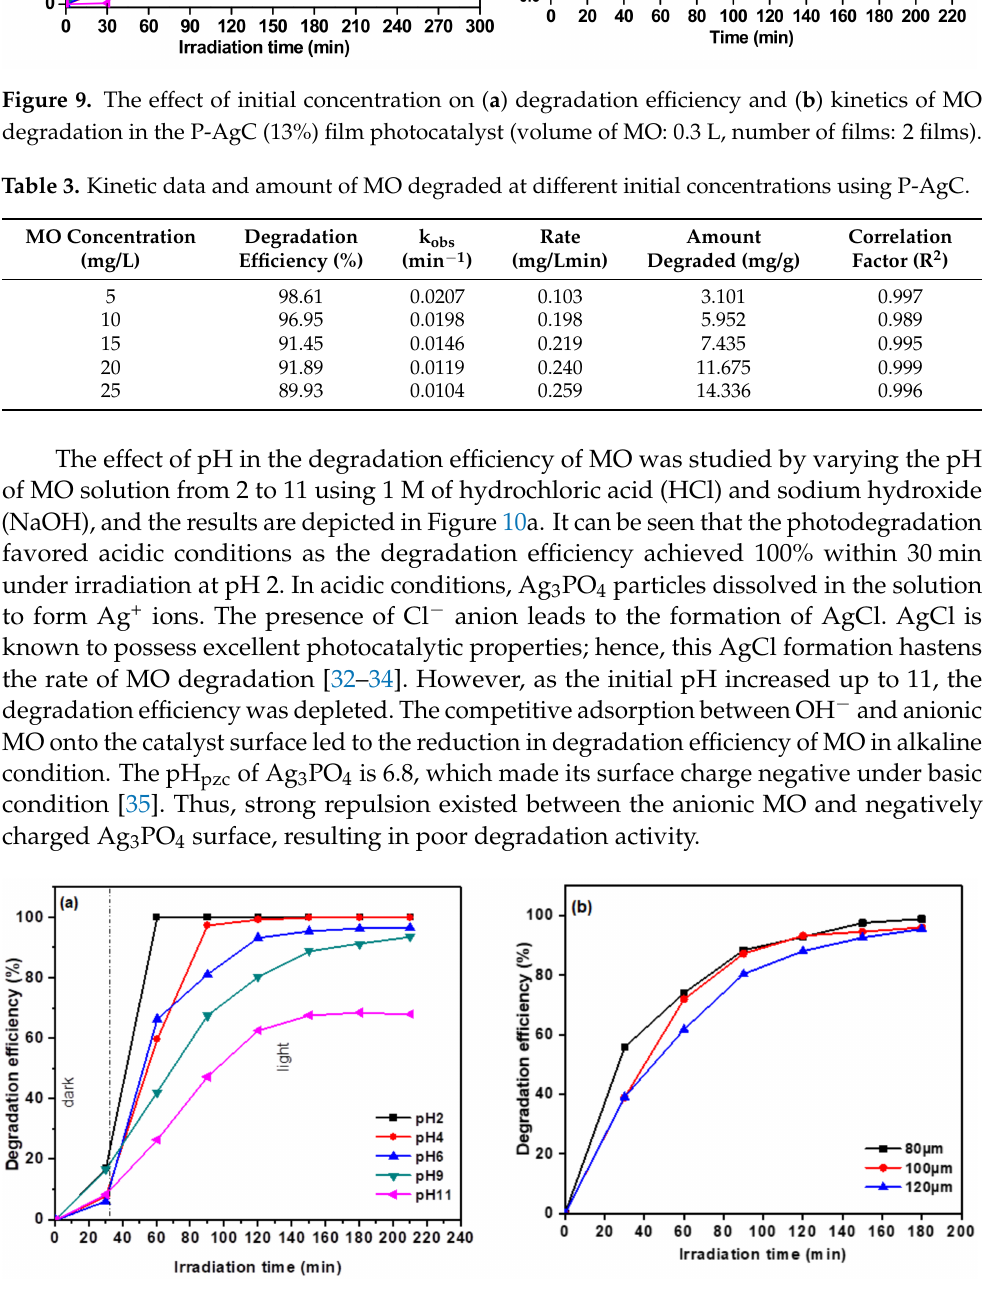
Figure 10. ( a ). Effect of initial pH of MO solution and ( b ) film thickness on degradation efficiency of P-AgC (13%) (volume of MO: 0.3 L, number of the film: 2 films, MO concentration: 10